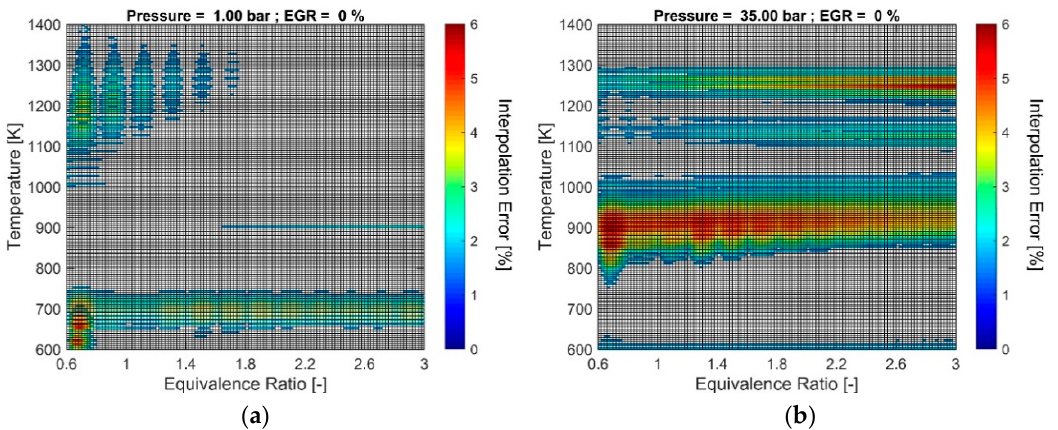
Figure 5. Error maps for the interpolation error ( ε MSD as defined in Equation (7)) between online and tabulated chemistry solver under constant pressure reactor conditions ( a ) at 1 bar and ( b ) 35 bar, both at 0% exhaust gas recirculation using n -heptane as fuel.